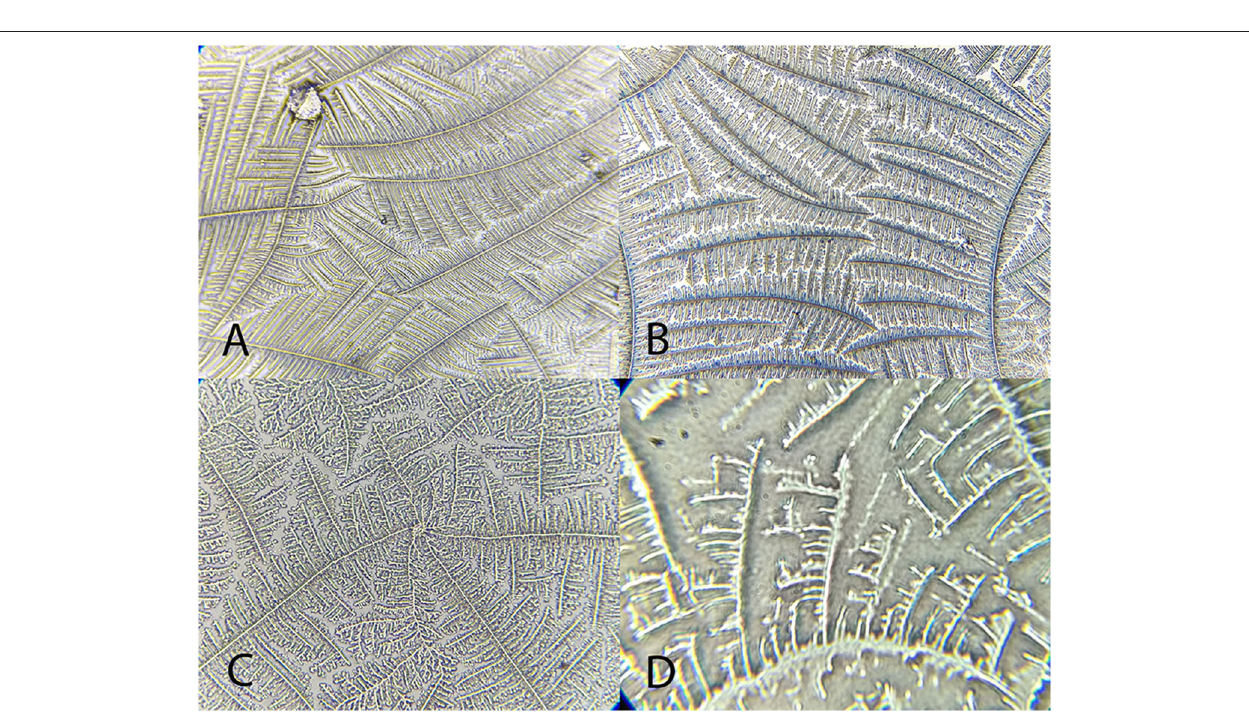
Frontiers in Veterinary Science |